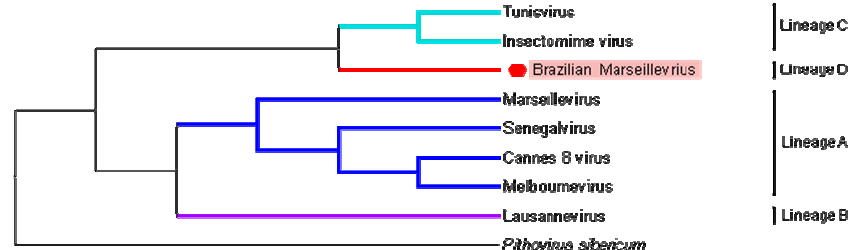
Figure 7. Supertree based on five phylogenetic trees. The five phylogenetic trees were built using FastTree and involved the DNA polymerase B, the major capsid protein, the VV-A18 helicase, the D6/D11 helicase and the D5 helicase amino acid sequences of the marseilleviruses and Pithovirus sibericum . The tree is rooted with Pithovirus sibericum used as an outgroup. Branches delineating the different lineages of the family Marseilleviridae are colored (dark blue for lineage A, purple for lineage B, blue for lineage C and red for lineage D).